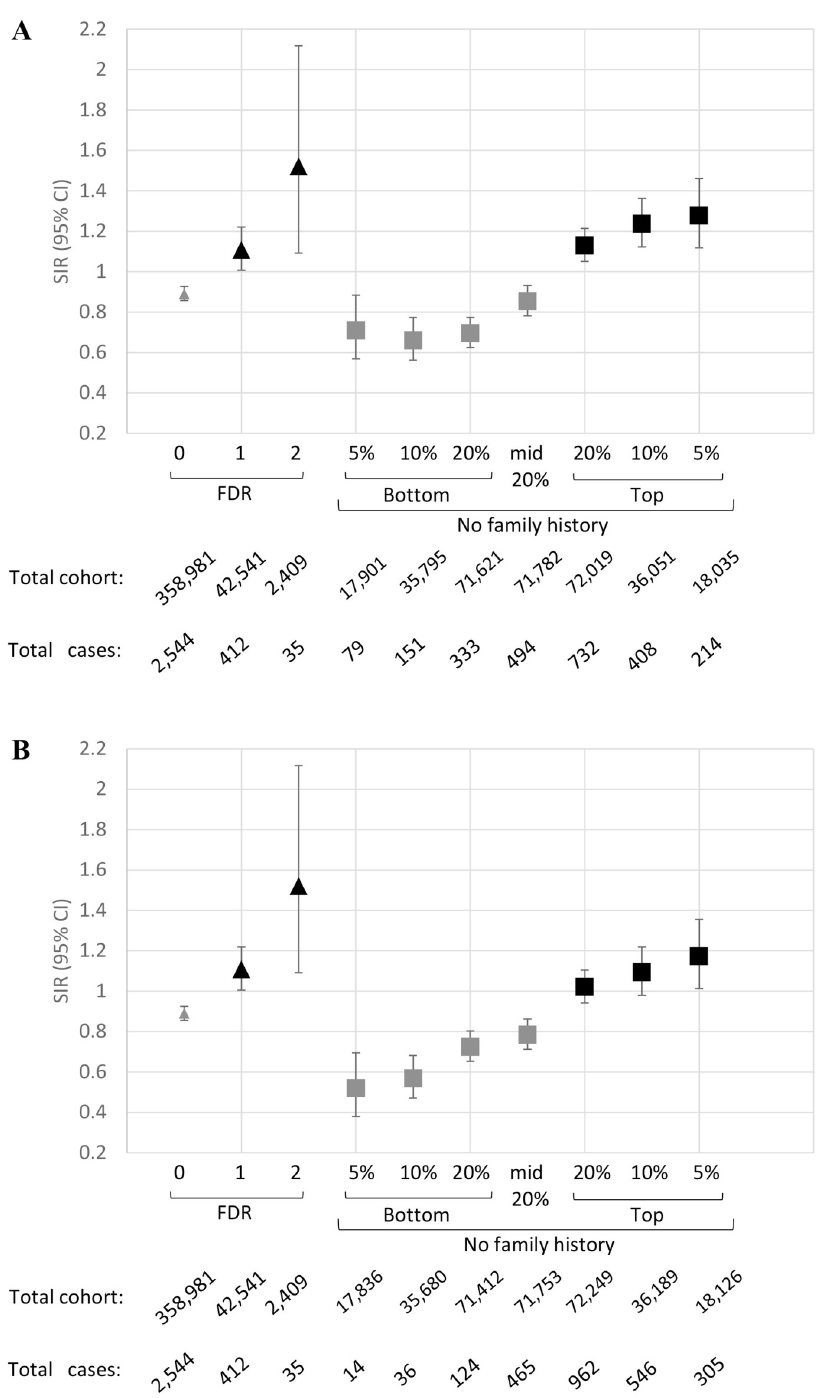
Fig 2. Comparison of the standardised incidence ratios (SIR) for different subgroups. SIR values were generated based on number of cases observed and expected using sex-specific UK population incidences for the number of affected first-degree relatives (FDR) vs the combined model for people without a family history. SIR values were plotted against number of affected first-degree relatives in comparison with full lifetime (A) and 10-year (B) risk categories for participants without family